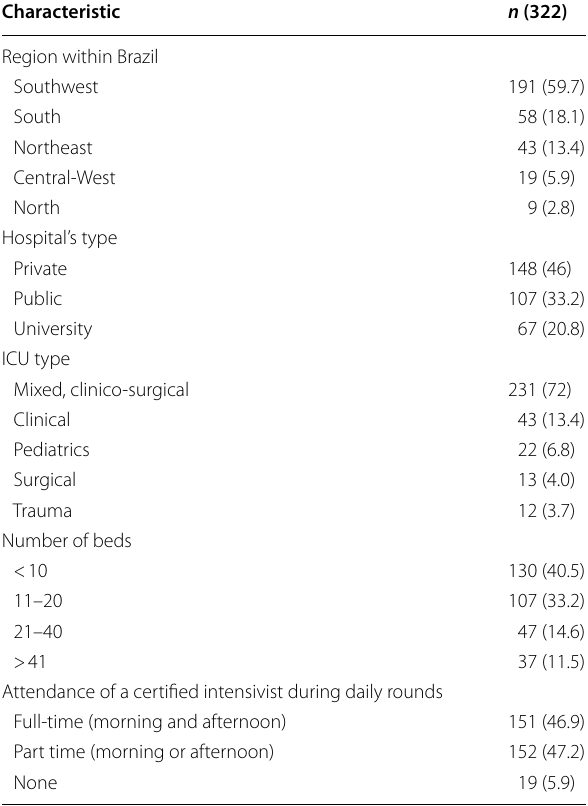
Table 1 Baseline characteristics of the study